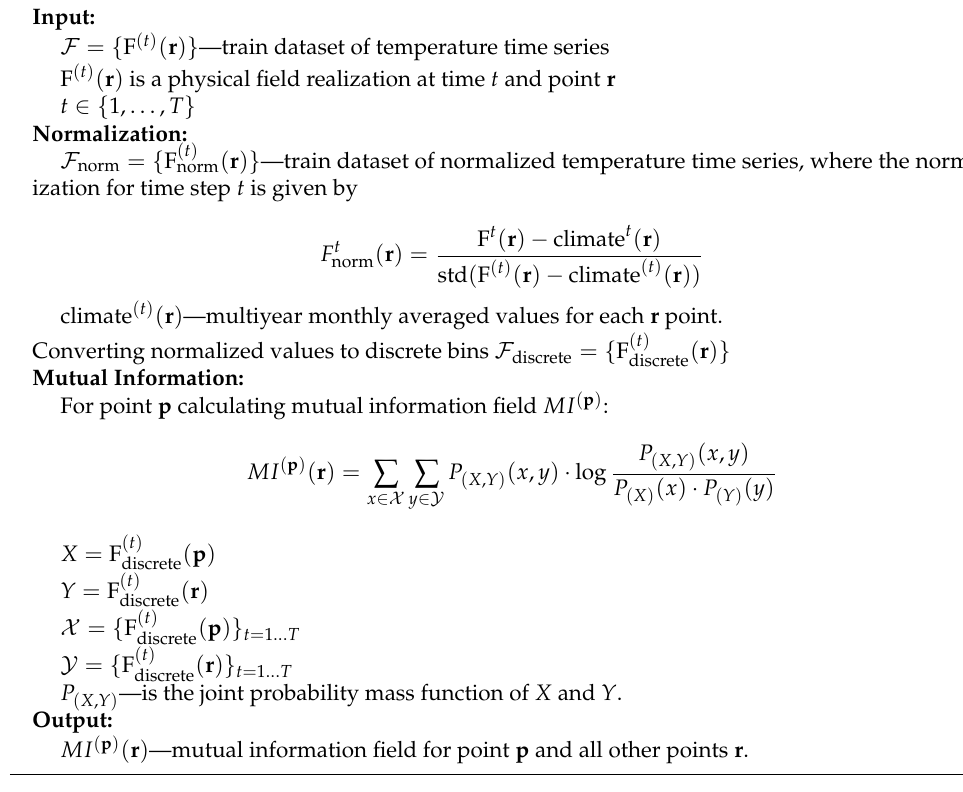
Algorithm 4 Mutual Information